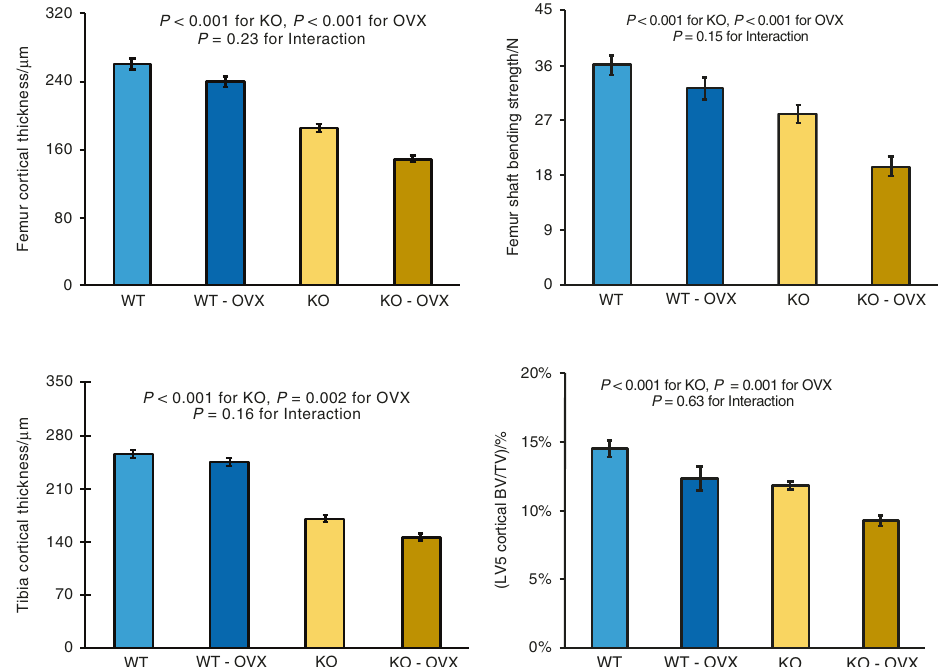
Fig. 4 Effects of Sfpr4 KO and ovariectomy on cortical bone parameters. Mice underwent ovariectomy or sham surgery at 16 weeks of age and bones were analyzed at 24 weeks of age. Data are means ± SEM for 9 to 11 mice per group, with statistical analysis by two-factor